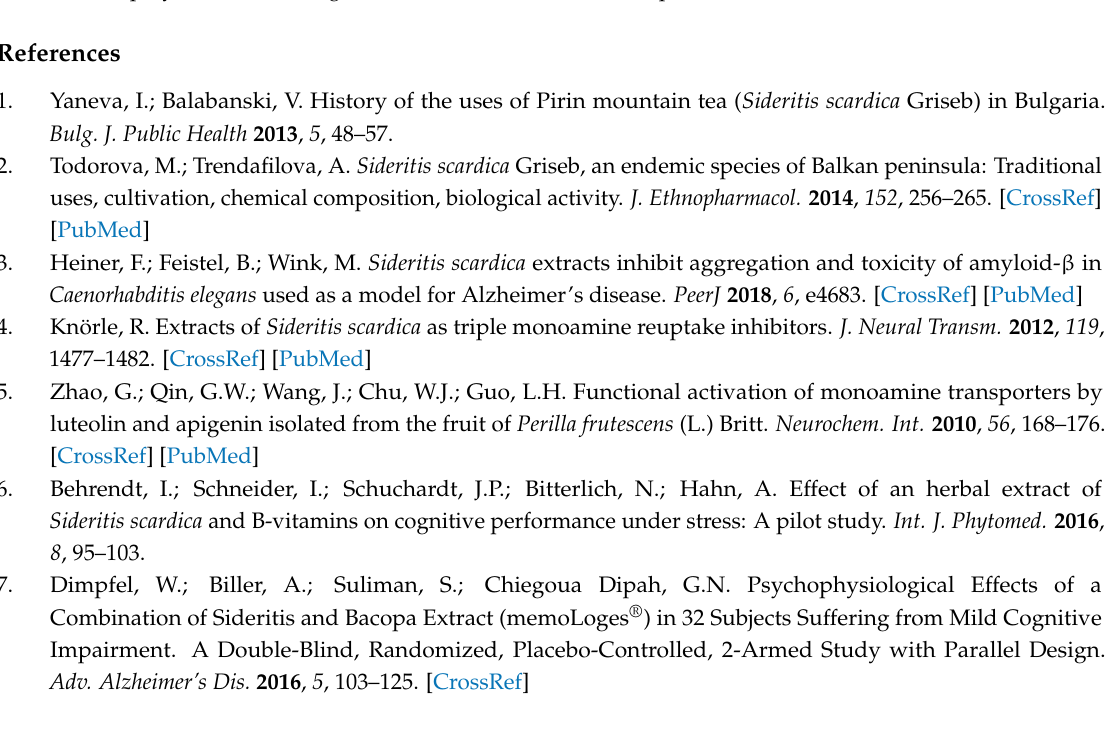
Table S1: Means and standard deviations (alongside in italics) of cognitive task performance during day 1 and day 28. Baseline and pre-dose data is raw whilst post-dose data is change from baseline. Author Contributions: All of the authors (E.L.W., P.A.J., J.F., J.K., F.H., B.F., C.G.S., I.P. and D.O.K.) were actively involved in the planning of the research described herein and in writing the paper. J.F. and J.K. also collected the data and all authors contributed to and reviewed the final publication. Funding: The study was sponsored by Finzelberg GmbH & Co. KG, Martin Bauer